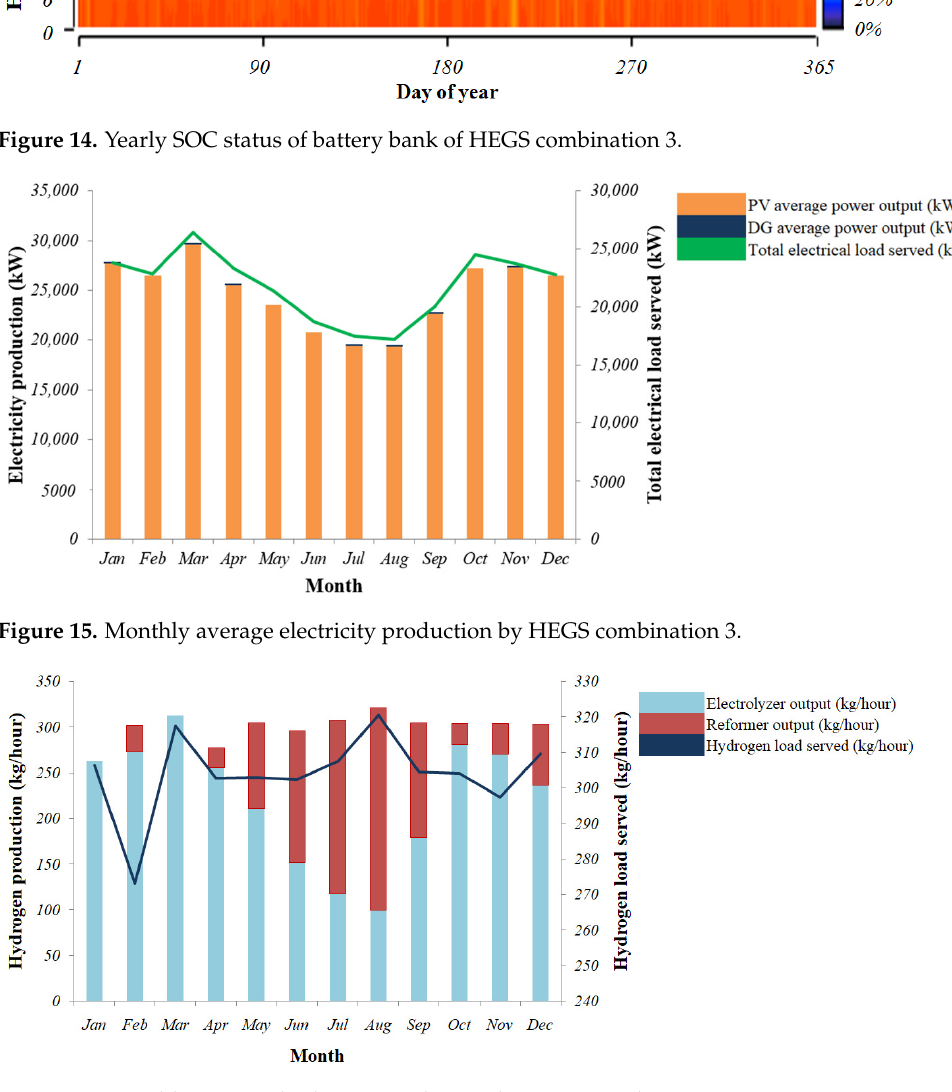
Figure 16. Monthly average hydrogen production by HEGS combination 3.